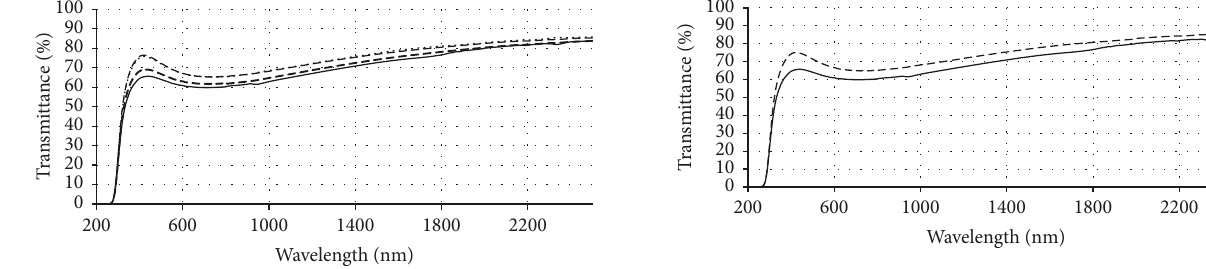
Figure 1: Effect of long-term UV exposure. The solid, dashed, and dotted lines correspond to as-deposited, one-hour, two-hour, and three-hour exposures, respectively. Note that there are two dotted lines that overlap.